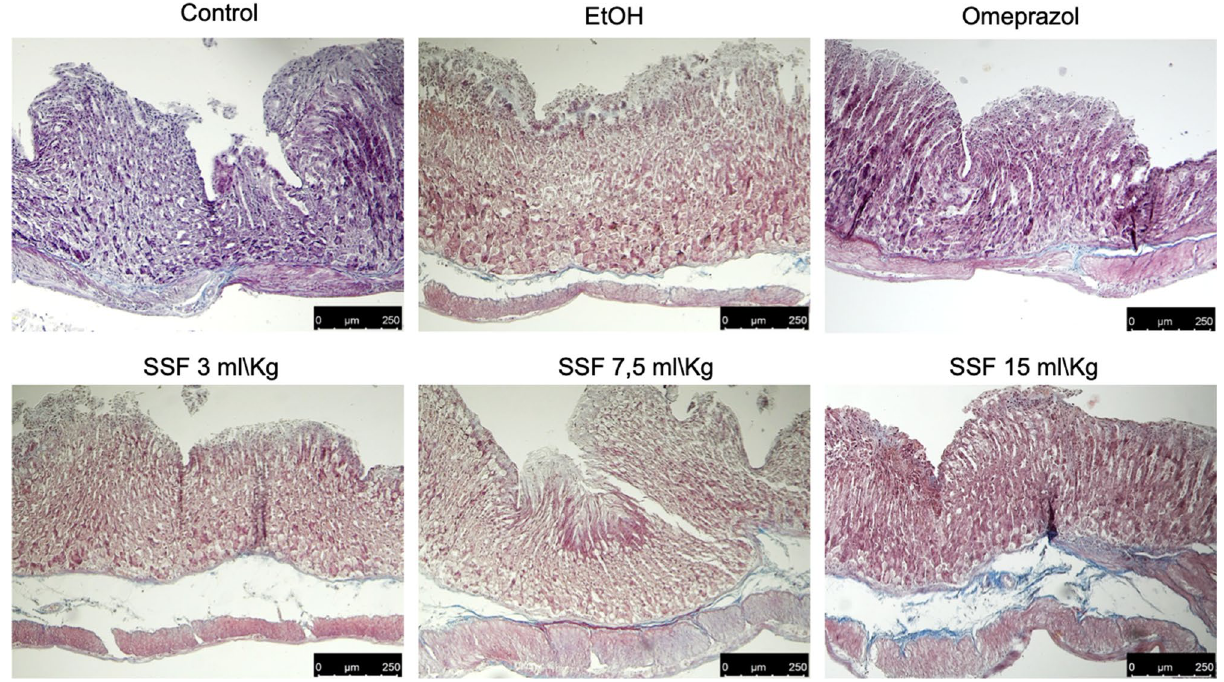
Figure 5. Representative image of collagen within mucosa layer using Masson’s trichrome staining. Control group showed the staining in healthy gastric tissue. EtOH group stain indicated fragmented and disorganized collagen fibers, while omeprazole group showed a significative protective effect. For the SSF treatment only the dose of 15 ml/Kg showed a significant protective